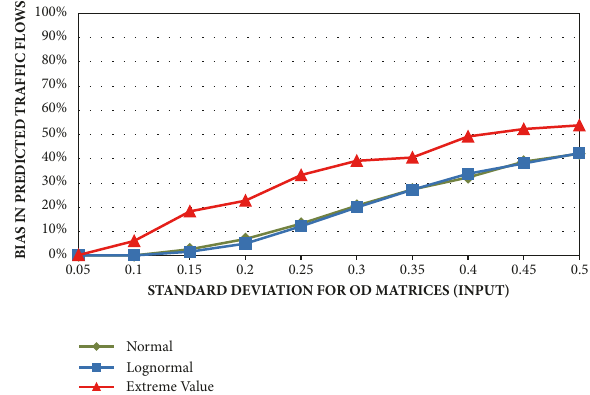
Figure 6: The relationship between the standard deviation for OD matrices (input) and the bias in the predicted traffic flows for link No. 6.